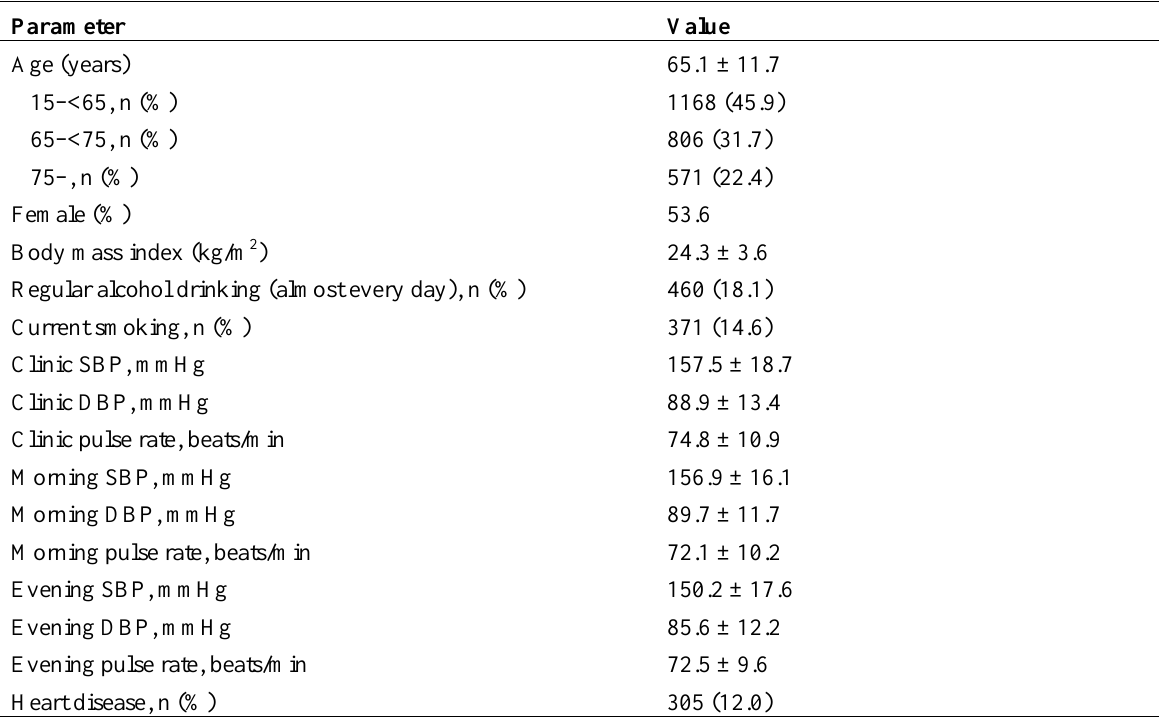
Table 1. Baseline characteristics of